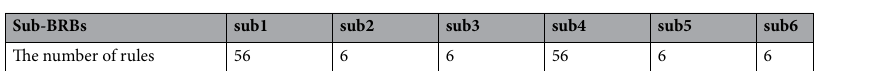
Table 15. The number of rules involved in optimization in each sub-BRB.